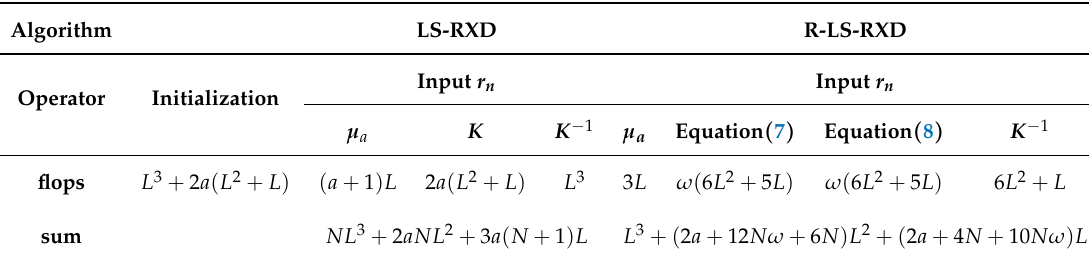
Table 2. Computational Complexity for local summation RXD (LS-RXD) and recursive local summation RXD (R-LS-RXD).